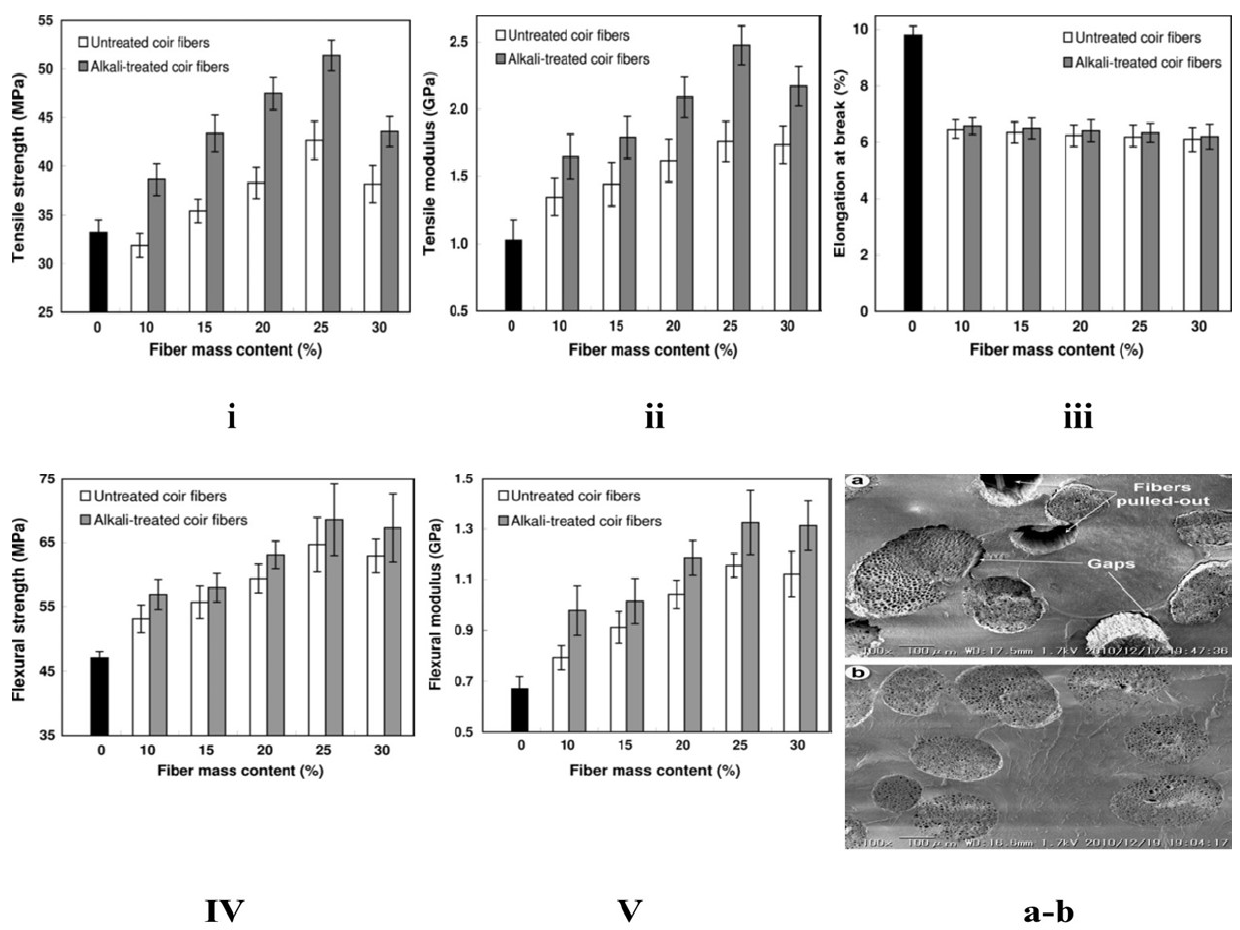
Figure 10. ( i ) Tensile strength; ( ii ) tensile moduli; ( iii ) fracture strain; ( IV ) moduli of rupture/bending strength; ( V ) bending modulus of unprocessed and 5N-72-treated coir-fiber/PBS biodegradable composites; and tensile fracturing surfaces of PBS biodegradable composite strengthened with 20% weight concentration of: ( a ) unprocessed coir fibers, ( b ) 5N-72 pro- cessed coir-fibers. Reproduced with permission from [303].